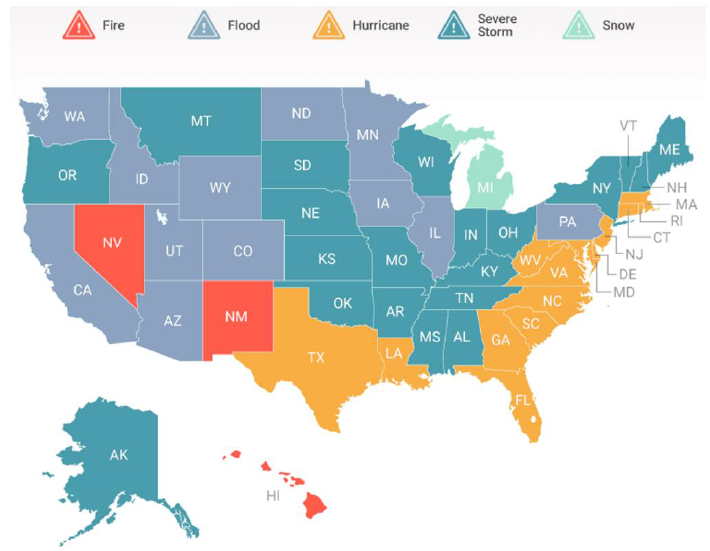
Figure 3. Number of recorded storms in the USA since the 1850s.